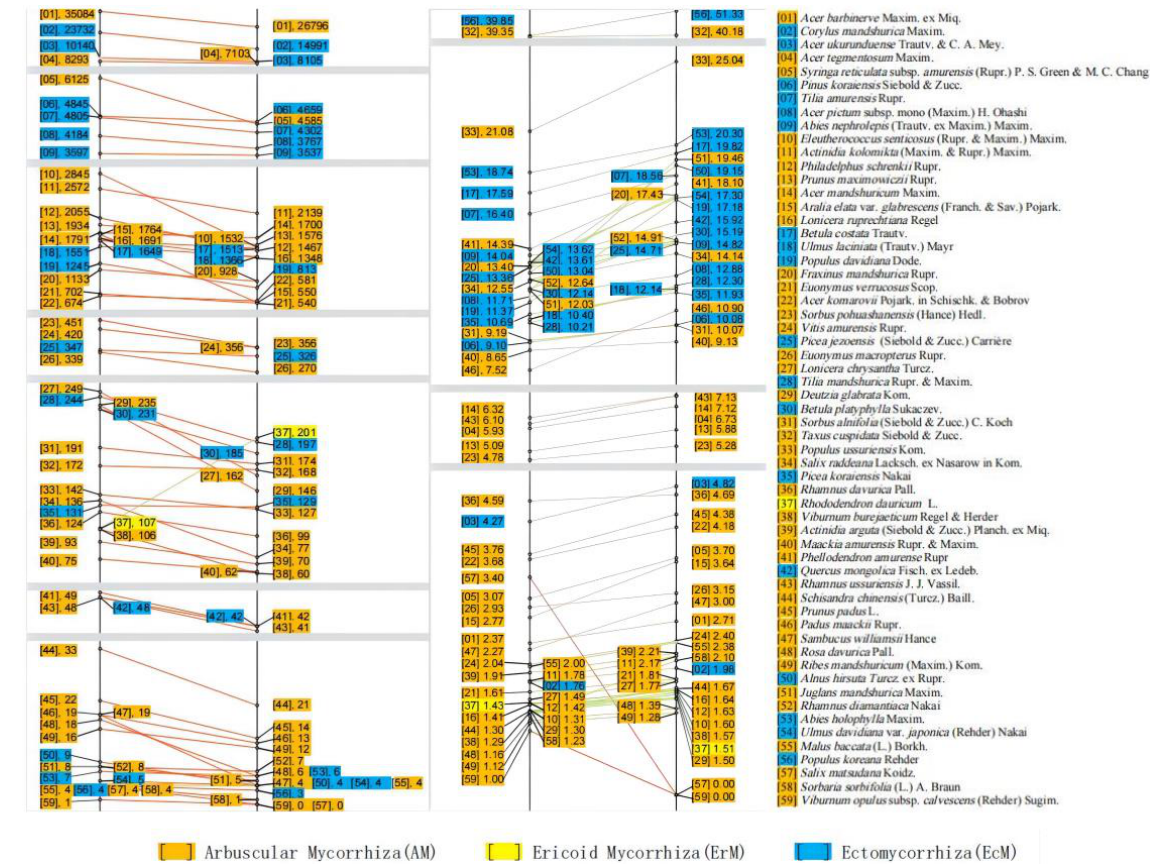
Figure 5 . Changes of quantity ( left ) and mean DBH ( middle ) of tree species with different mycor- rhizal types.